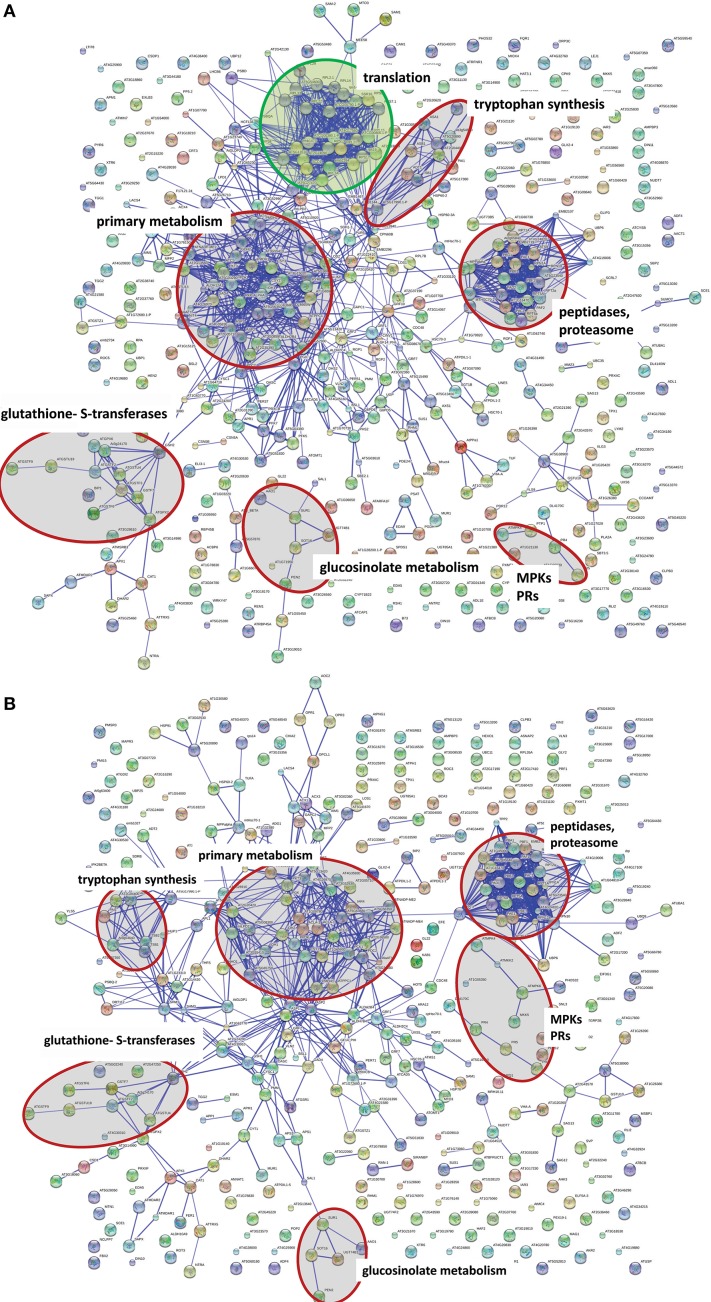
Network comparison of protein extract between wild type DD and mpk3. DEX treatment causes a wide range of protein changes that can be organized in networks. Network calculation was done with STRING 9.05 (high confidence score 0.7, confidence view). Either the Arabidopsis locus identifier or the protein name abbreviation (where known) are shown. Selected functional clusters are highlighted in red. STRING network of the up-regulated protein in Col-0 DD plants (A) and the mpk3 DD plants (B). The green circle marks a cluster of proteins involved in protein translation, which is completely missing in the mpk3 mutant.